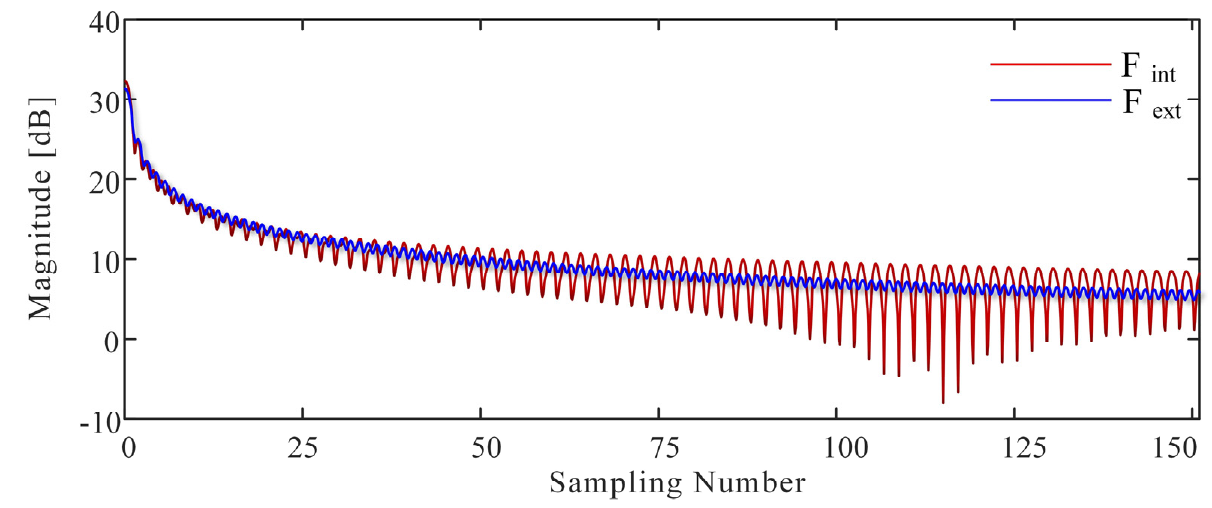
Figure 3. V DC frequency spectrum under external (DC-bus) and internal fault.